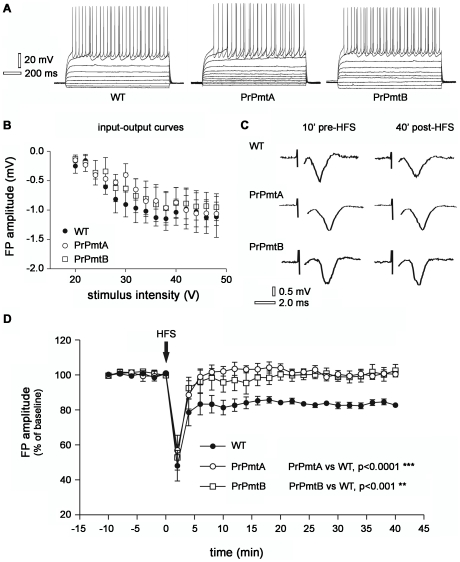
Electrophysiological analysis demonstrates absent long term depression (LTD) in corticostriatal slices of old mice.Voltage traces of striatal medium spiny neurons (MSNs) recorded in whole-cell patch-clamp during hyperpolarizing and depolarizing steps of current. Note the similar firing pattern discharge in the representative WT, PrPmtA and PrPmtB neuron (A). Graph showing a similar input-output curve of striatal field potential (FP) evoked by 200 µsec stimuli of increasing voltage intensities applied on corticostriatal fibers in WT, PrPmtA and PrPmtB mice (B). Representative examples of corticostriatal FP acquired 10 min before high frequency stimulation (HFS) protocol and 40 min after HFS in WT, PrPmtA and PrPmtB mice (C). Time-course of FP amplitudes showing the induction of LTD only in WT mice, whereas no long-lasting change of the FP amplitude in PrPmtA and PrPmtB mice is monitored up to 40 min following the HFS protocol application (D). The significance level was established at p<0.001 (**) and p<0.0001 (***).